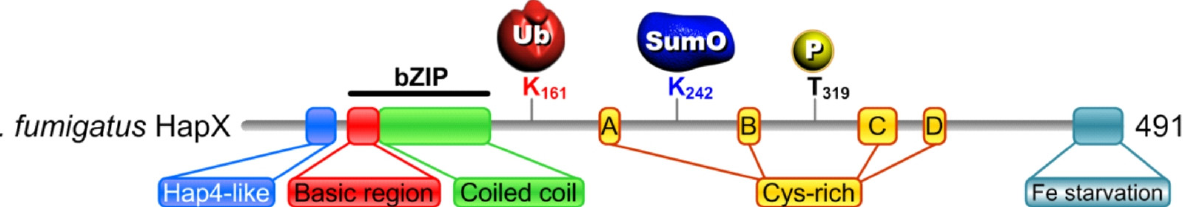
Figure 1. Schematic representation of the A. fumigatus HapX domain organization. The N-terminal Hap4-like CBC binding domain (CBC-BD) is shown in blue. Basic region and coiled coil domains of the bZIP domain are depicted in red and green, respectively. Cysteine-rich regions are marked in yellow. Cysteine-rich regions A and B are essential for HapX function during iron excess but not during iron starvation, while the C-terminus, shown in turquoise, is crucial during iron starvation. Post-translational modifications of residues K161 (ubiquitination), K242 (sumoylation) and T319 (phosphorylation), objects of this study, are shown in dark red, blue and yellow,